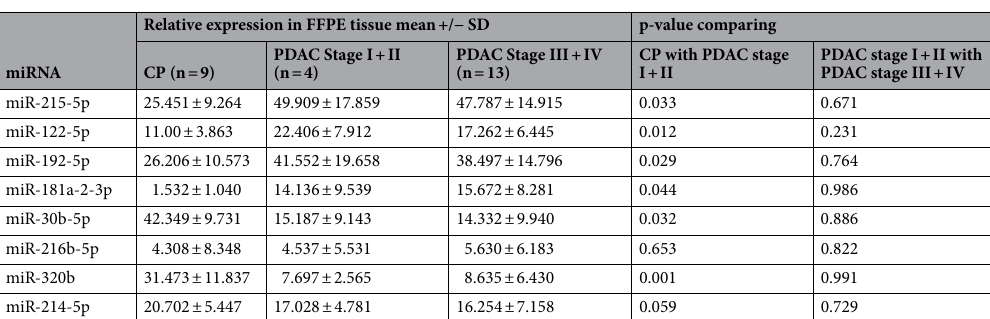
Table 2. Comparison of relative expression of miRNAs in FFPE tissue samples of CP and different stages of PDAC.